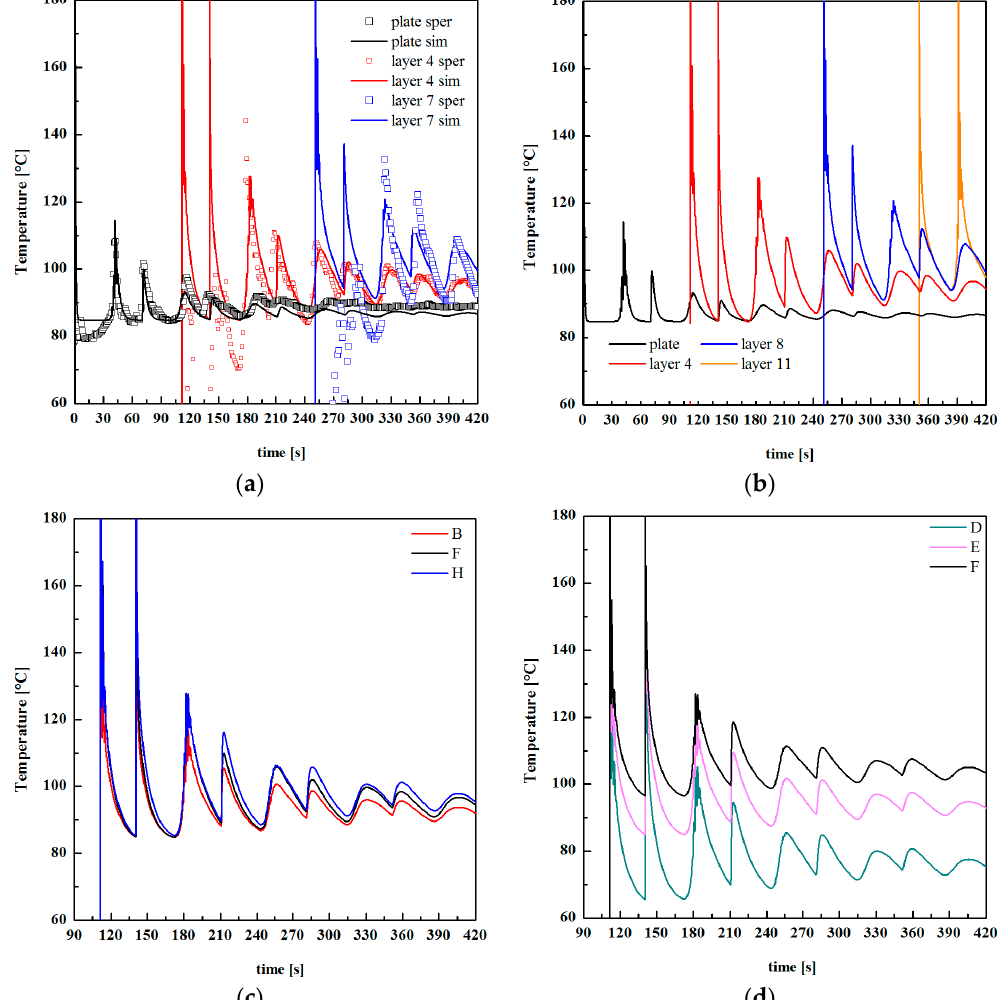
Figure 15. ( a ) Comparison among temperature evolution recorded during FDM case F (symbols) and the simulated temperature evolution (lines); ( b ) temperature evolutions evaluated by simulation of different layers for the case F; ( c ) temperature evolutions evaluated by simulation of different layers for the cases B, F and G; ( d ) temperature evolutions evaluated by simulation of different layers for the case D and F.